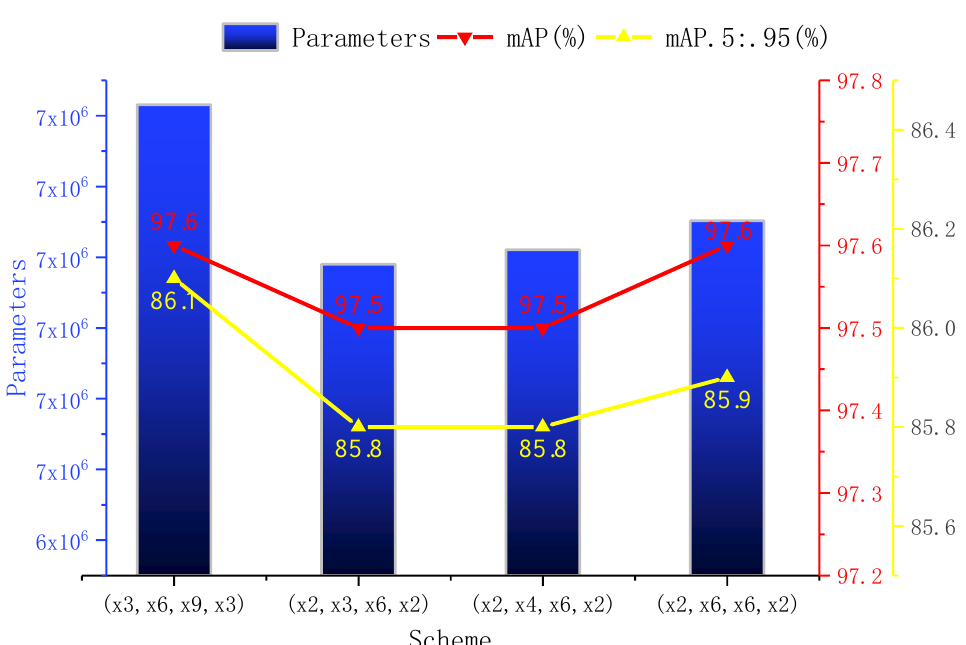
Figure 7. The Optimization of the C3 module. Content within the “()” represents the number of C3 modules in the backbone network.